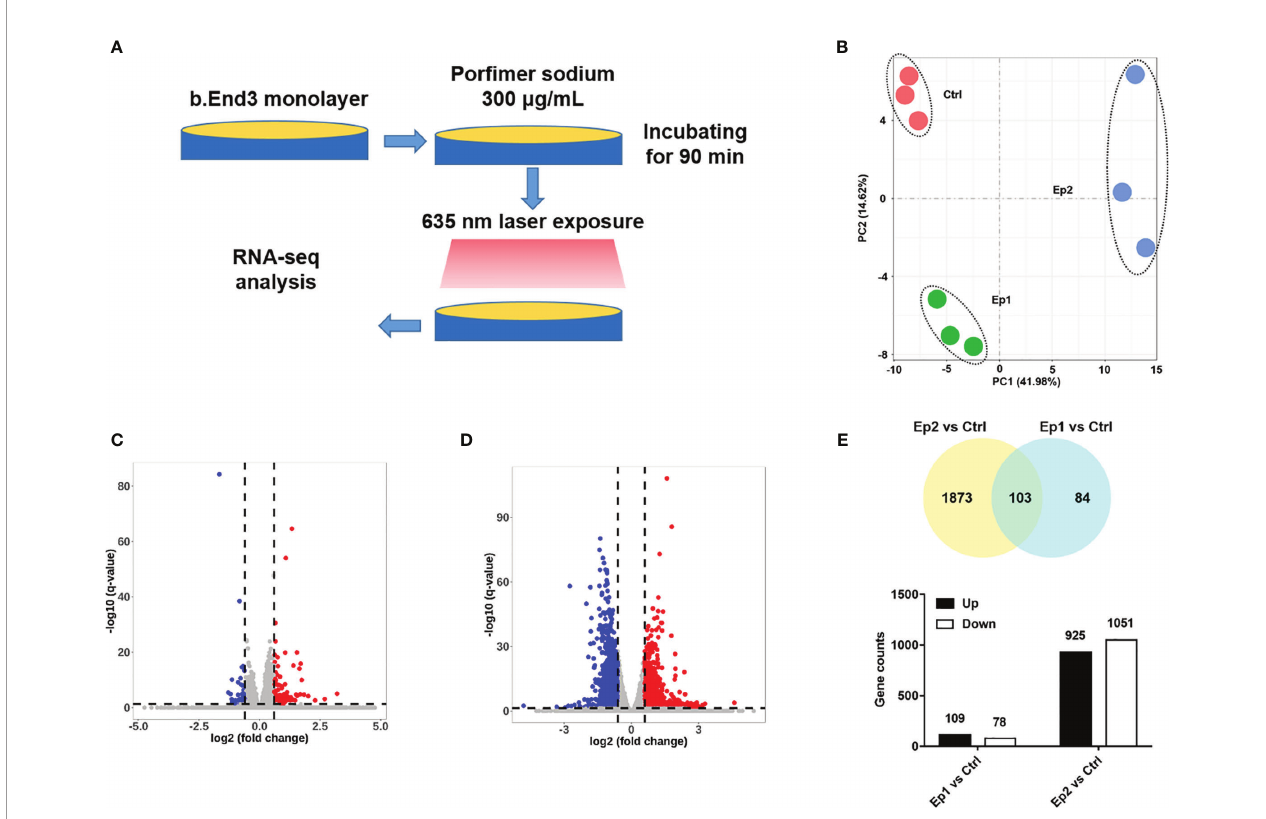
FIGURE 2 | (A) Schematic illustration of RNA-sequencing protocol in this investigation. (B) PCA analysis of RNA-seq samples based on the genetic components. (C, D) Volcano plot of expressed genes based on the intervention dosage. (E) Statistical results of different genes (p-adj <0.05 and |log 2 FoldChange|>0.6).